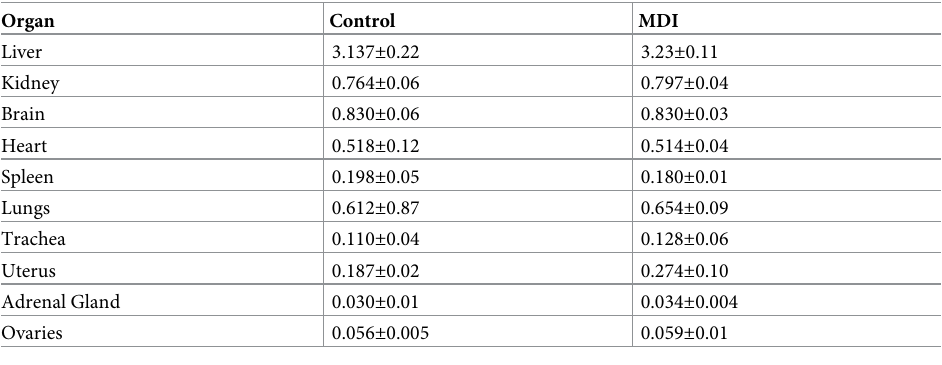
The values are expressed as mean ± SD, n =